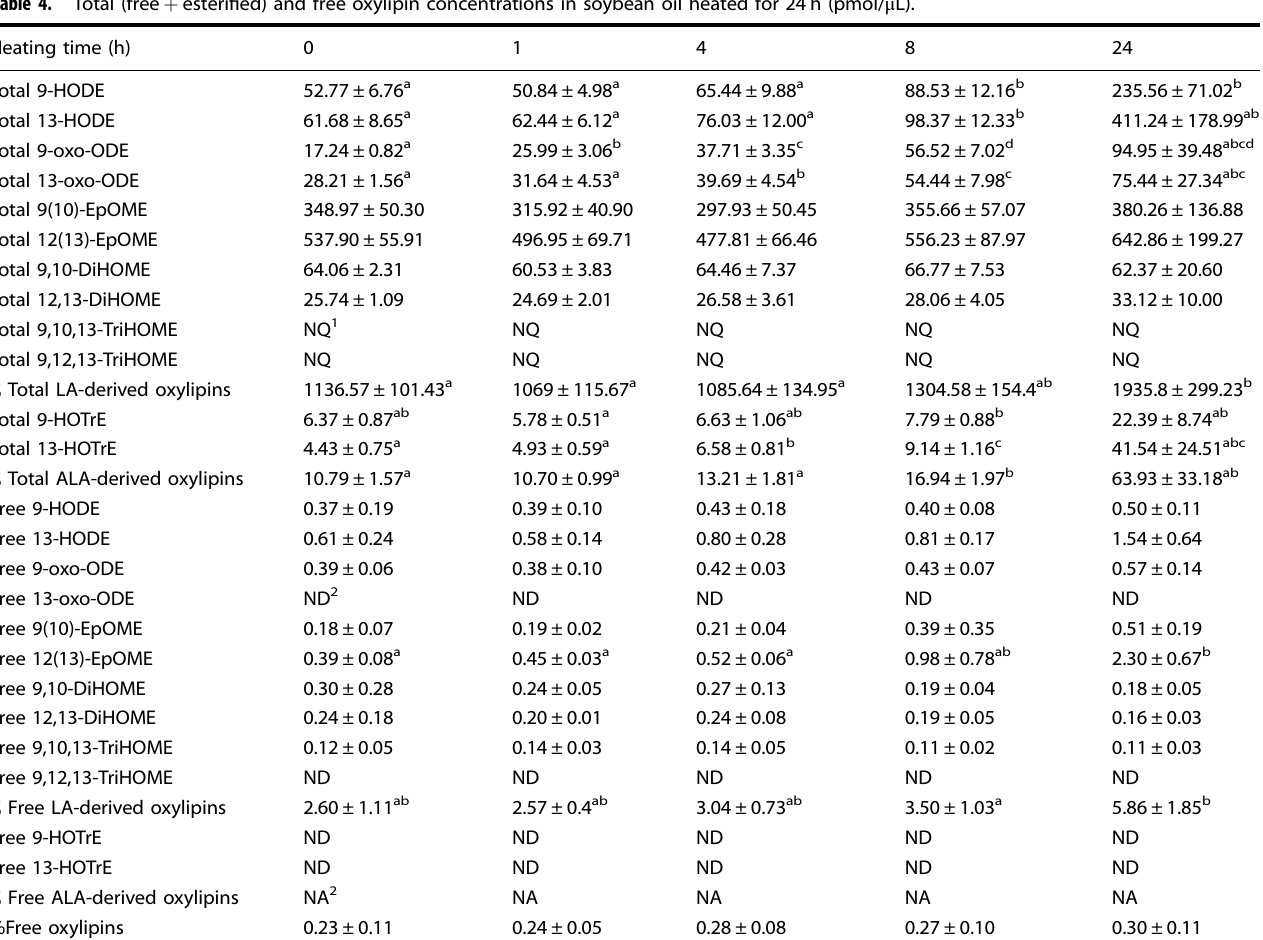
Table 4. Total (free + esteri fi ed) and free oxylipin concentrations in soybean oil heated for 24 h (pmol/ μ